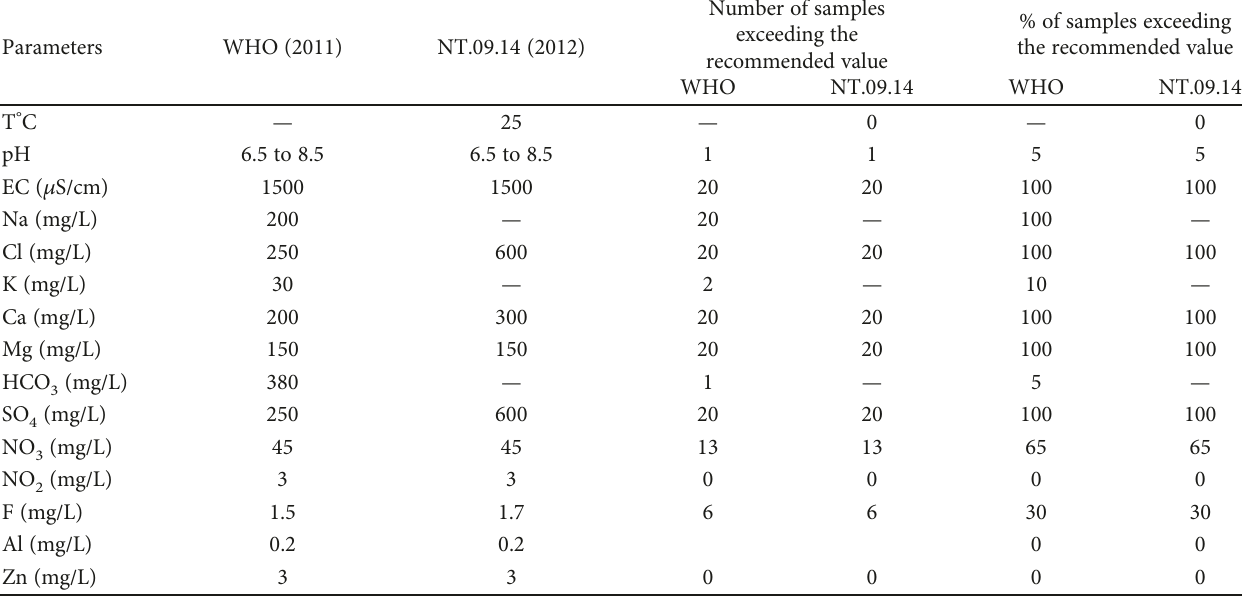
Table 6: Water quality of the Skhira aquifer with respect to WHO standards [44] and Tunisian standards [45].